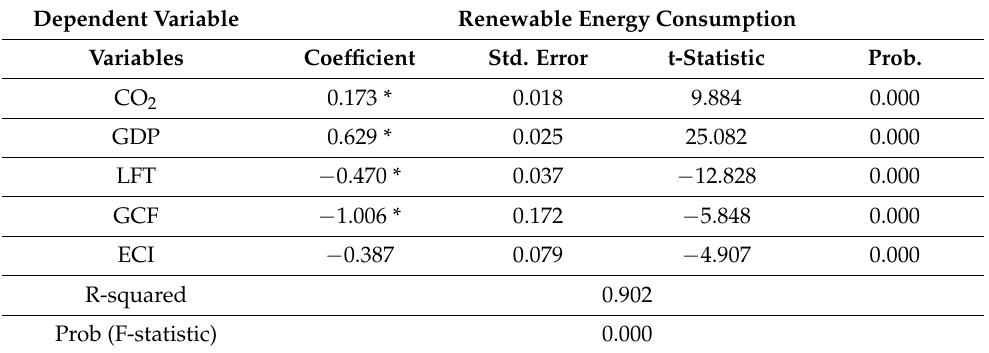
Table 8. Panel Generalized Method of Moments